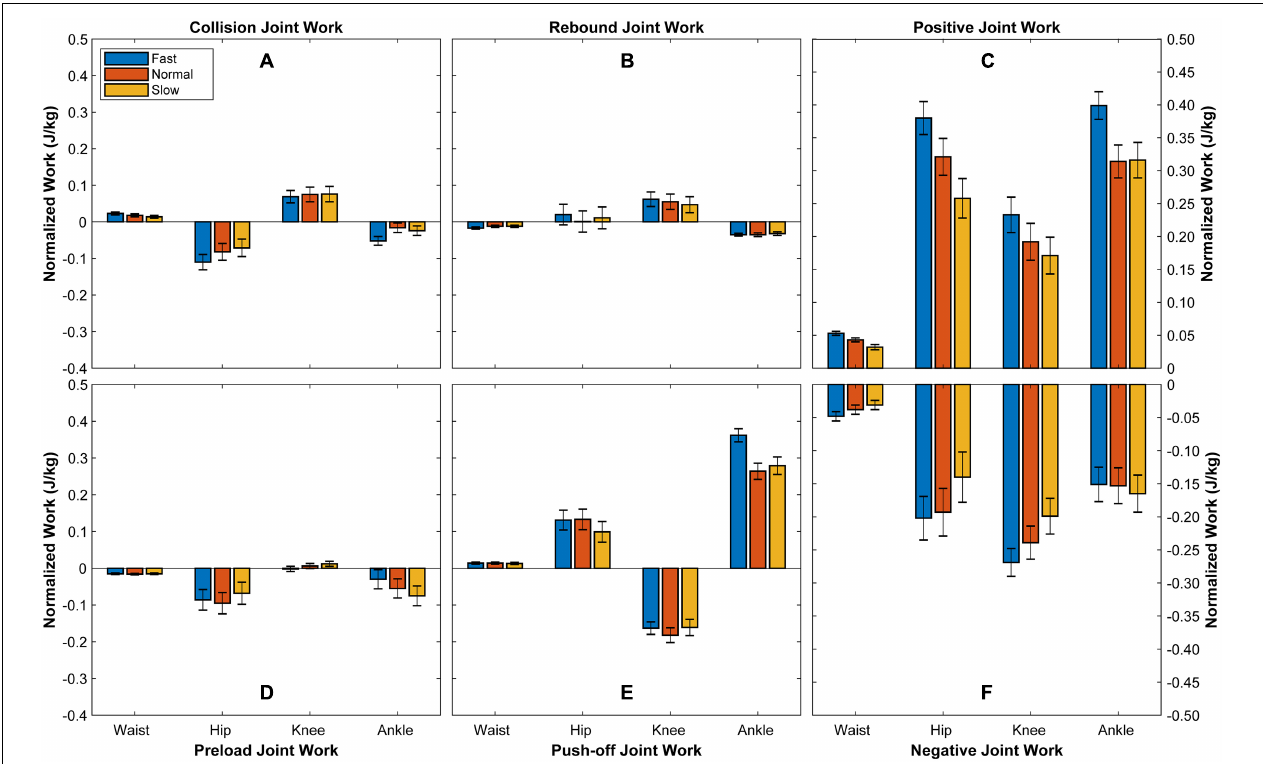
FIGURE 1 | Mechanical works of joints during stance phase. It illustrates the mechanical work produced by each joint during collision (A) , rebound (B) , preload (D) , and push-off (E) , as well as the positive (C) and negative (F) mechanical work produced by each joint during the whole stance phase. Bars depict mean; N = 6; error bars,